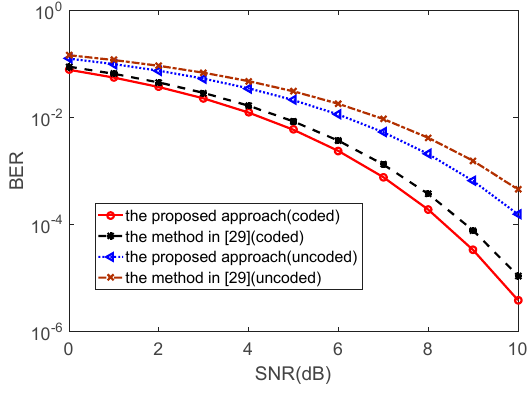
Figure 10. The SERs versus SNR for BPSK.